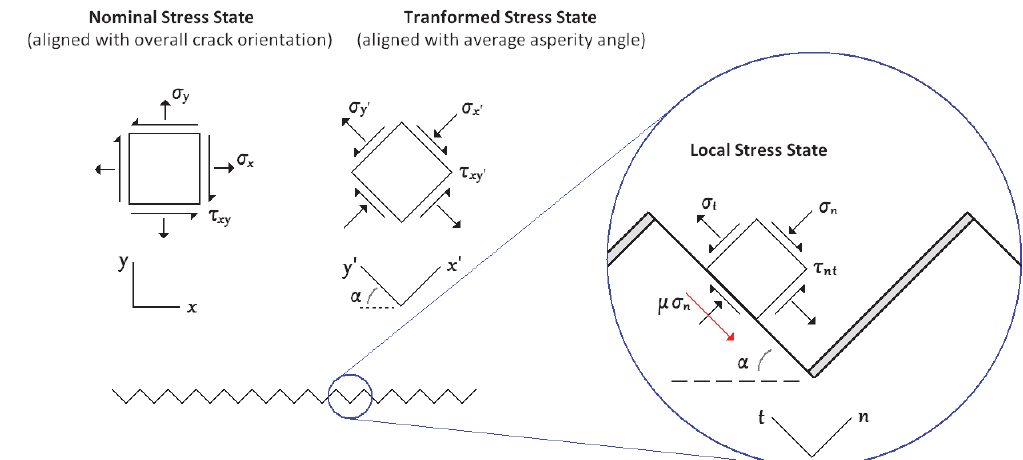
Figure 6: Schematic showing coordinate systems and nomenclature relevant to the proposed frictional attenuation model The friction stress acting at the crack interface is calculated by multiplying the compressive normal stress, σ x’ , by a coefficient of friction, µ , which represents the friction between opposing crack faces under ideal contact